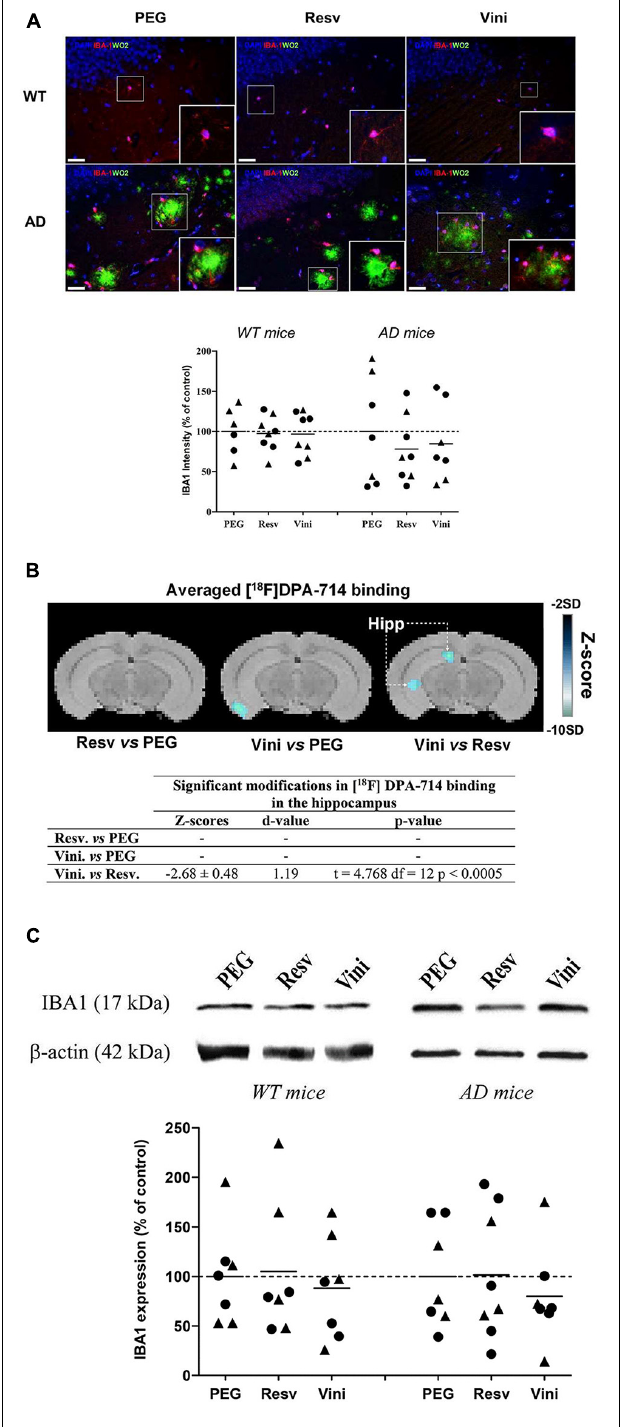
FIGURE 2 | Effects of resveratrol and viniferin on the microglia reactivity. The WT mice and the double transgenic APPswePS1dE9 mice were treated by resveratrol, trans ε -viniferin or their vehicle (PEG 200) intraperitoneally from 7 to 11 months of age. (A) The senile plaques were stained with antibody against amyloid peptide (clone WO2, green), microglia with antibody against IBA1 (red), and the nuclei with DAPI (blue). On each image, a magnification